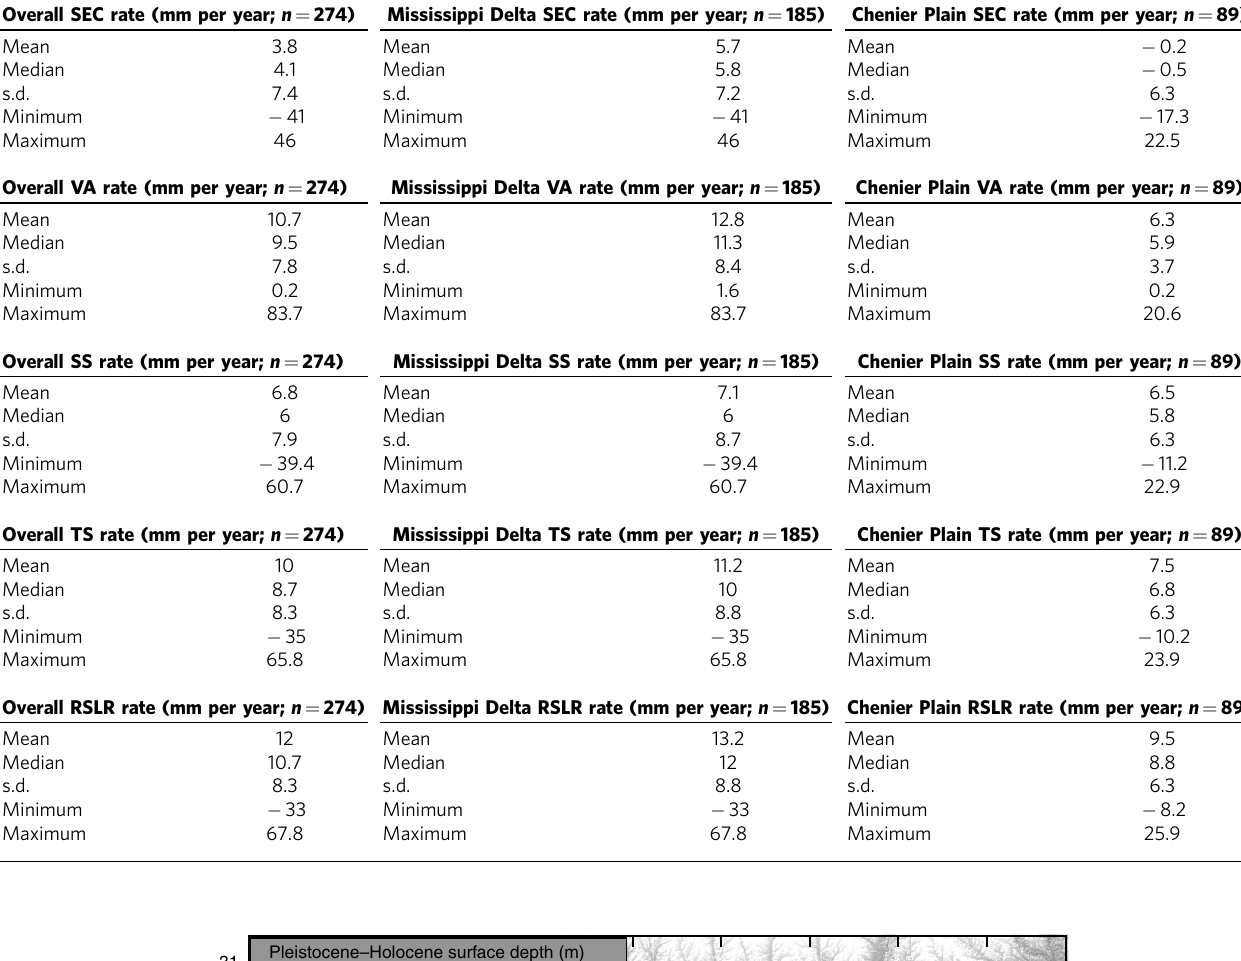
Table 1 | Rates of change in coastal Louisiana wetlands.